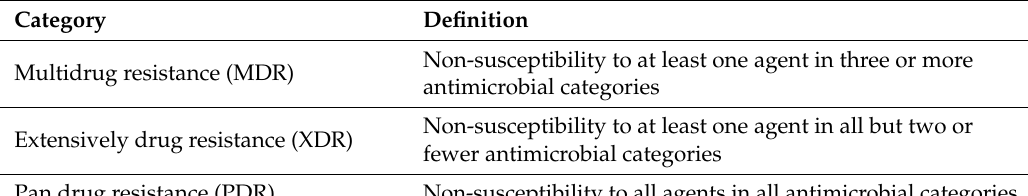
Table 2. Definitions of the various categories of drug resistance. Adapted from Reference